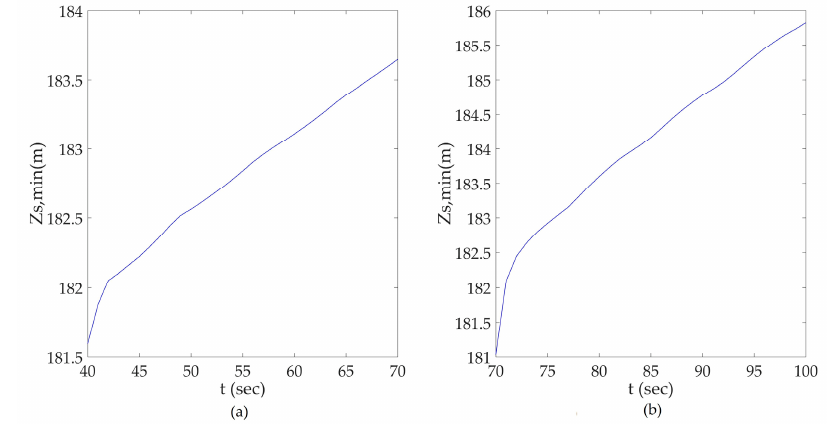
Figure 13. Time lag for the load acceptance by unit 2 (a) and unit 3 (b) .